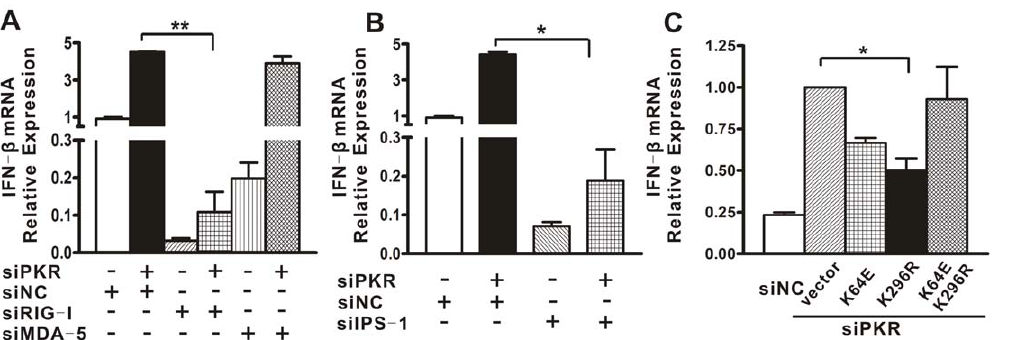
Figure 7. Suppression of poly(I:C) induced IFN by PKR required RIG-I/IPS-I and dsRNA binding activity of PKR. (A, B) A549 cells were co-transfected with siRIG-I, siMDA-5 or siIPS-1 together with siPKR1 or siNC followed by poly(I:C). Total cellular RNA levels were analyzed for IFN- b using real-time PCR and normalized to those of GAPDH in each sample. (C) Cells were transfected with pcDNA6, pcDNA6-K64E, pcDNA6-K296R or pcDNA6-K64EK296R followed by siNC or siPKR1 transfection, and were then stimulated by poly(I:C). Total cellular RNA was analyzed for IFN- b expression by real-time PCR and normalized to that of GAPDH in each sample. Data are shown as mean 6 SEM at least three independent experiments. *p , 0.05, **p , 0.01.